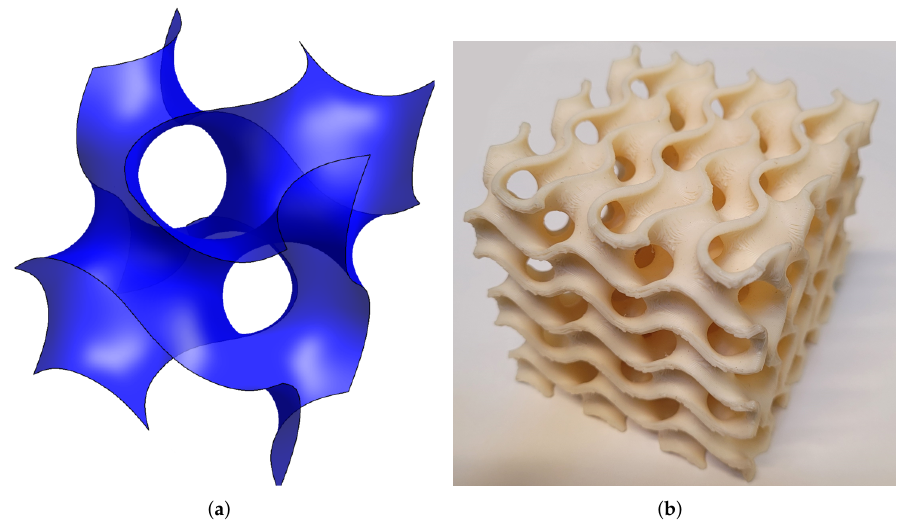
Figure 1. Examples of the gyroid geometry. ( a ) A 3D rendering of the gyroid minimal surface; ( b ) 3D printed